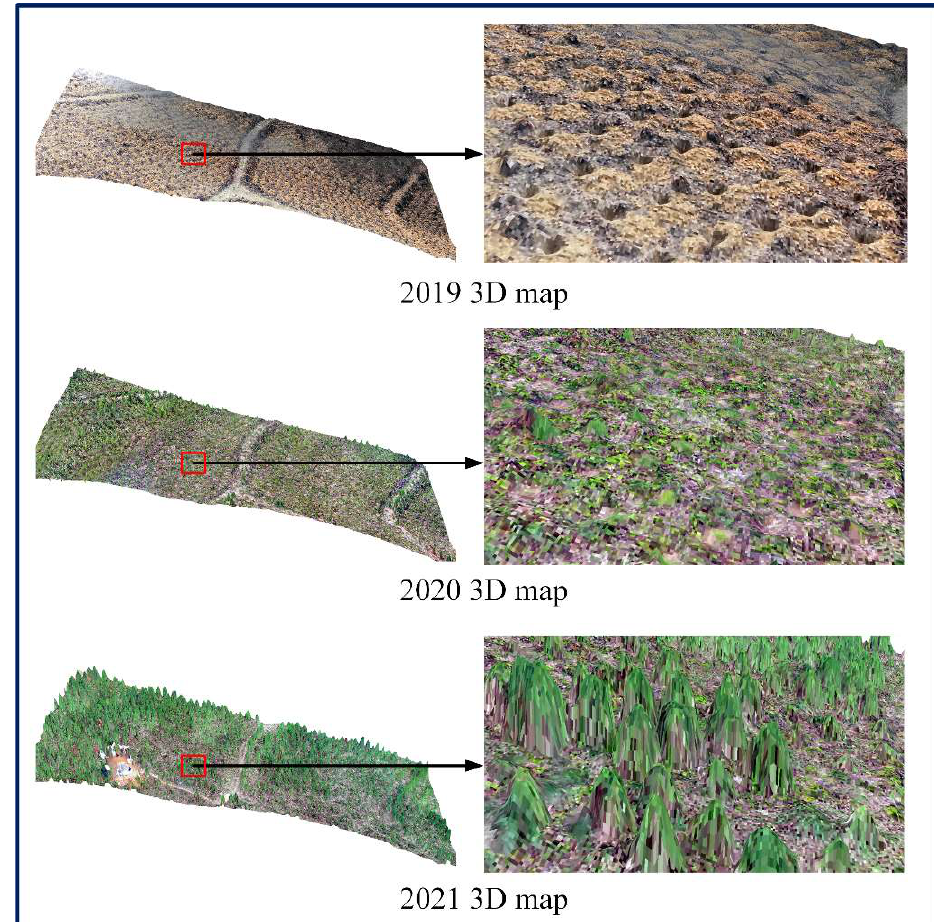
Figure 12. Young forest height changing 3D map based on UAV image point cloud.